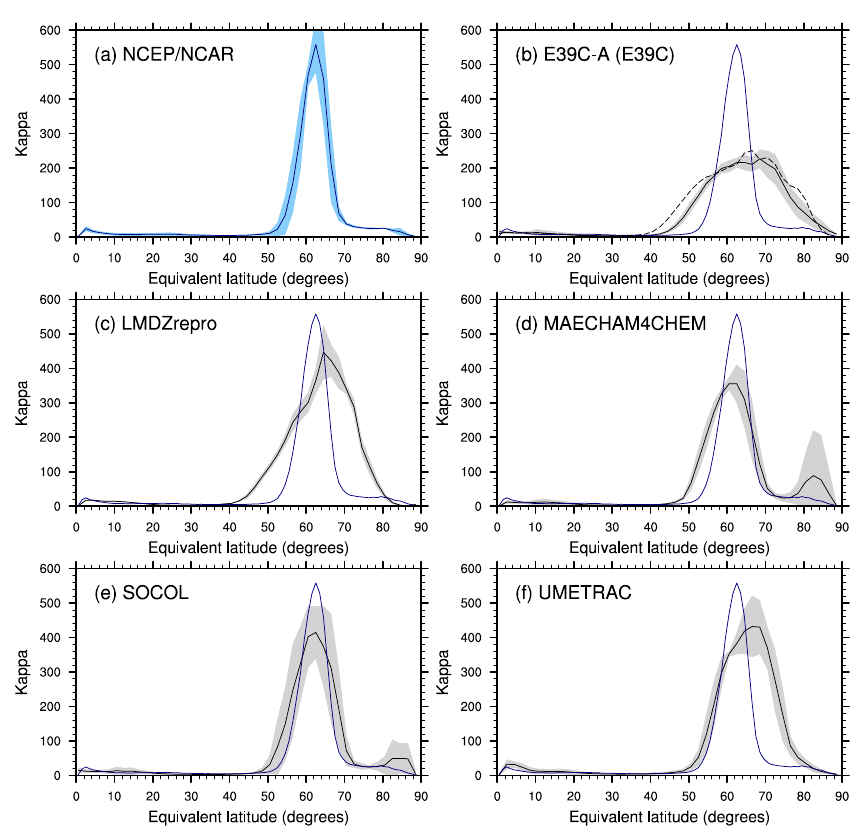
Fig. 3. Five year (1995-1999) average October κ from (a) NCEP/NCAR reanalyses and (b) E39C-A (dashed line E39C), (c) LMDZrepro, (d) MAECHAM4CHEM, (e) SOCOL and (f) UME- TRAC. Shading indicates the 1 σ standard deviation about the mean. The blue lines are the reanalysis mean overlaid on the model results for comparison.